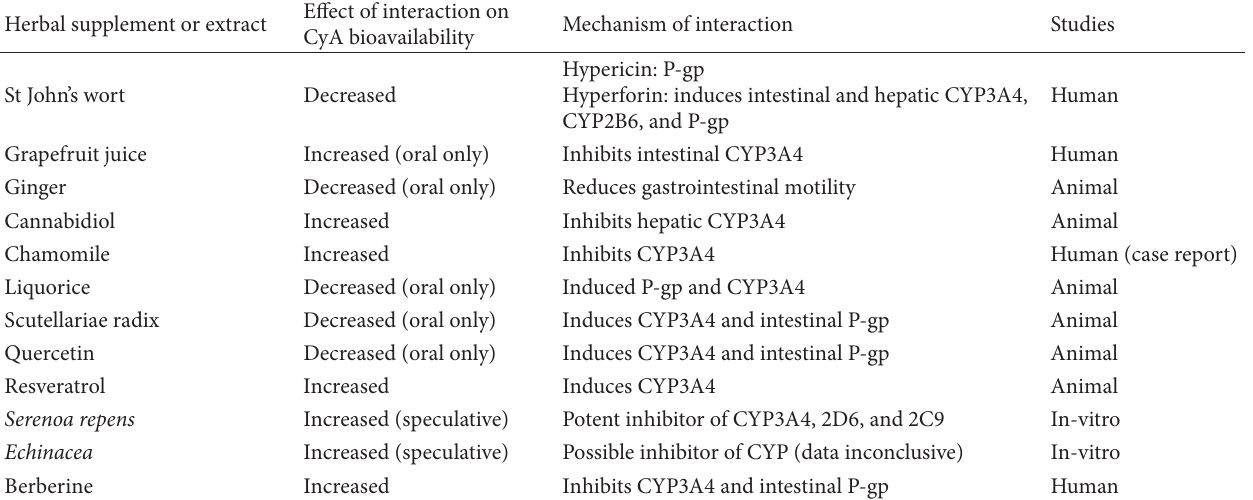
Table 1: A summary of commonly used herbal extracts, effect of herbal extract-cyclosporine A (CyA) interaction, and the mechanisms involved if